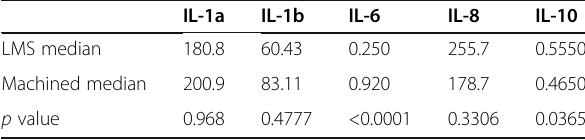
Table 4 Cytokine median level for LMS vs M abutments